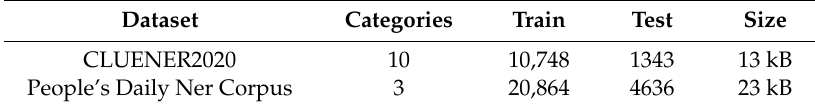
Table 1. Description of two representative datasets.